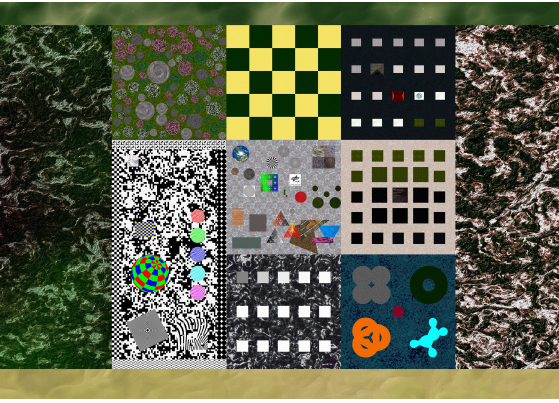
Figure 2. Synthetic 3D test scene with its core area and parts of the surrounding